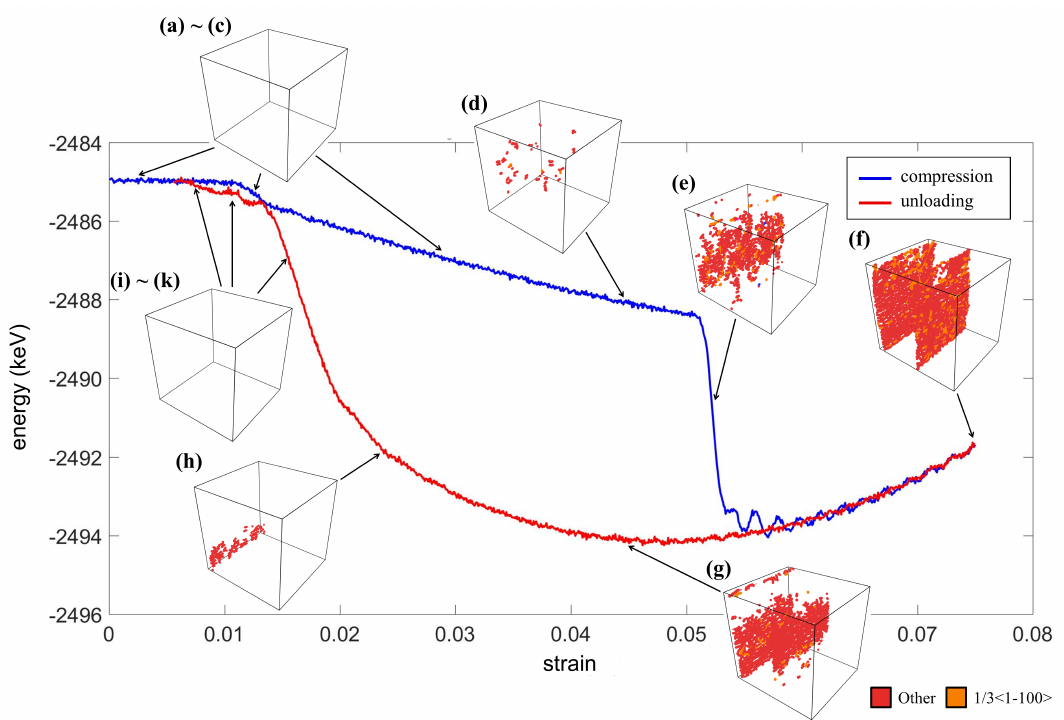
Figure 5. The energy profile and the evolution of dislocation at stages ( a – k ) during the compressive